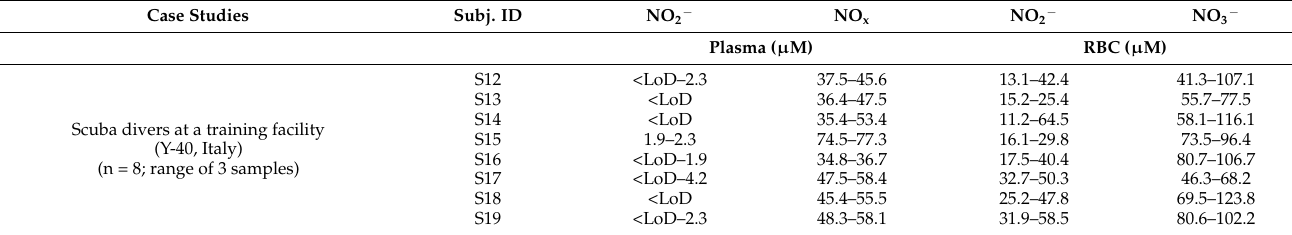
Table 7. Nitrite and nitrate concentrations in plasma and red blood cells of scuba